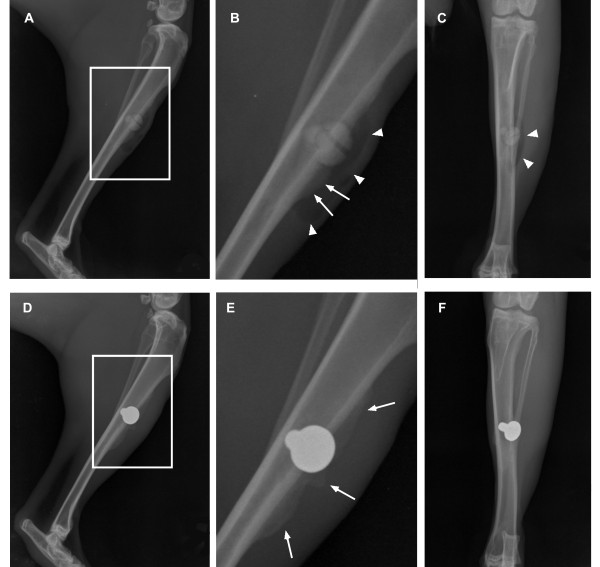
Radiographs of two rabbit tibiae four weeks post operation. (A) Medio-lateral projection of a rabbit tibia with an implanted MgCa0.8 screw. (B) Magnification corresponding to the white rectangle in (A). (C) Cranio-caudal projection of the same tibia. New bone (white arrows) and accumulation of gas (white triangles) are clearly observable at the implantation site of MgCa0.8. (D) Medio-lateral projection of a rabbit tibia with an implanted S316L screw. (E) Magnification corresponding to the white rectangle in (D). (E) Cranio-caudal projection of the same tibia. At the implantation site of S316L only new bone (white arrows) is detectable.